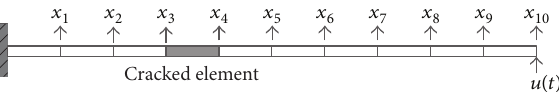
Figure 8: Finite element model of a cantilever beam.